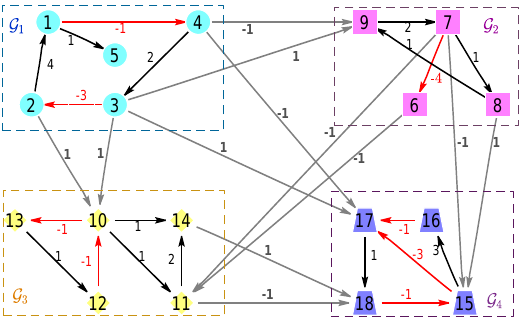
Figure 2. The acyclic partition topology for four groups with cooperative–competitive